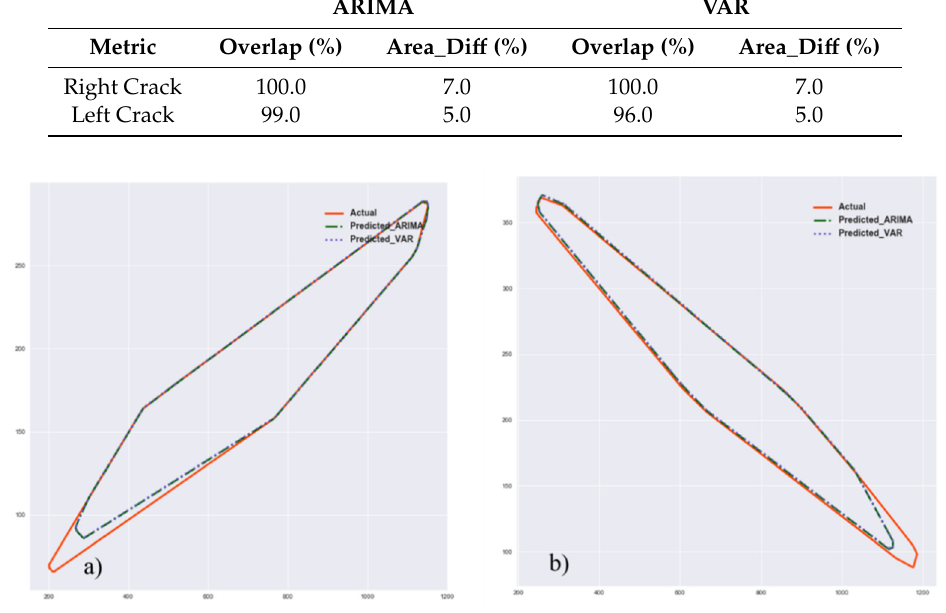
Table 4. Comparison of predicted crack shape from ARIMA and vectorized autoregression (VAR) against ground truth.